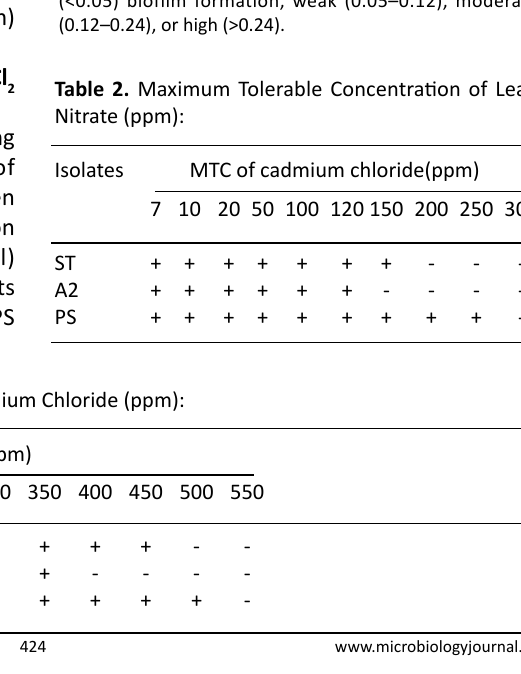
Table 1. Biofilm formation by micro-titer plate at OD nm for three bacterial isolates: Isolates